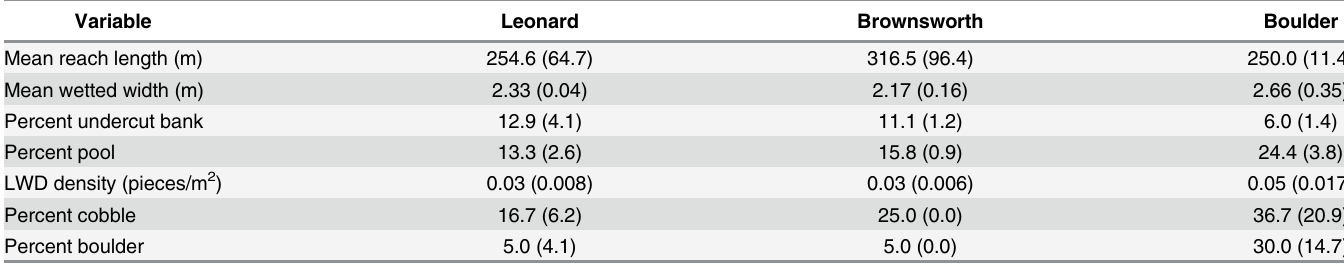
Table 1. Physical habitat characteristics (mean ± SD) in Leonard, Brownsworth, and Boulder creeks (Oregon, USA). Variable Leonard Brownsworth